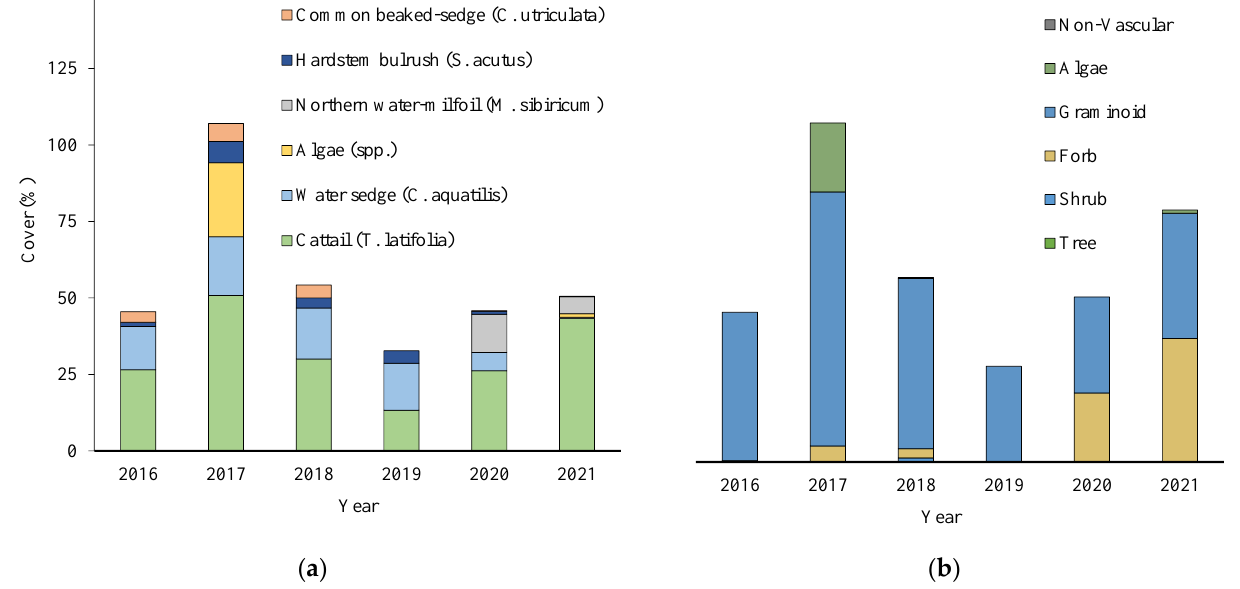
Figure 2. Average percent cover of species ( a ) and vegetation type ( b ) in the shallow cells of the Kearl Treatment Wetland from 2016 – 2021. Total percent covers may add up to greater than 100% where layers of (vascular and non-vascular) vegetation overlap.